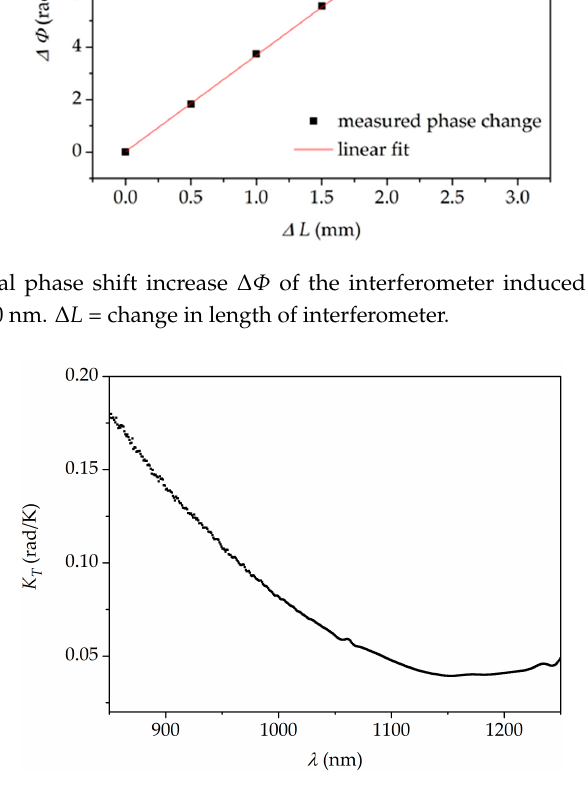
Figure 7. Spectral sensitivity to temperature K T of the TCF measured for the temperature change from 25 °C to 86 °C.